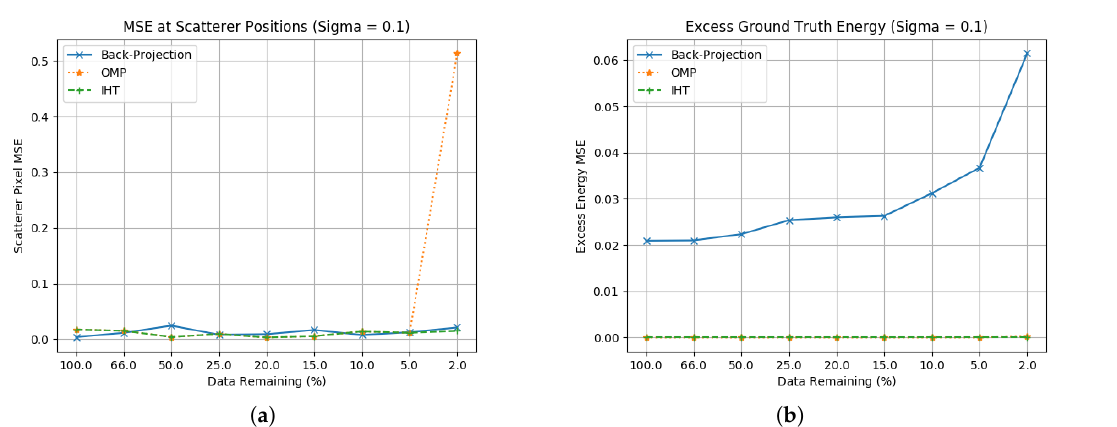
Figure 7. Ground truth estimation statistics for hard-limited CS methods. ( a ) Scatterer location RCS error including noise ( σ = 0.1); ( b ) Excess energy including noise ( σ =